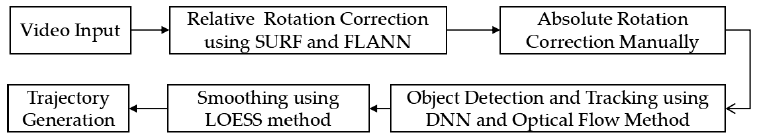
Figure 1. Trajectory generation workflow.